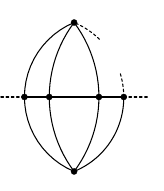
Figure 13 . Kite graph obtained by cutting ( y, v 1 ) , ( y, z 2 ) and ( y, v 2 ) .